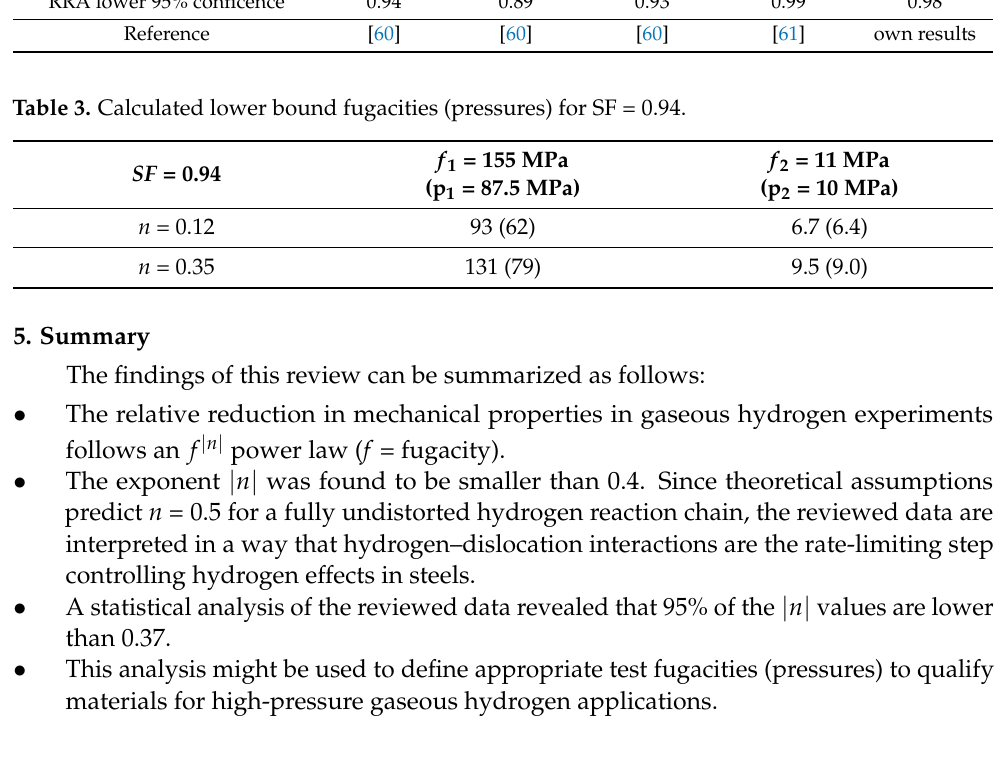
Table 3. Calculated lower bound fugacities (pressures) for SF = 0.94.